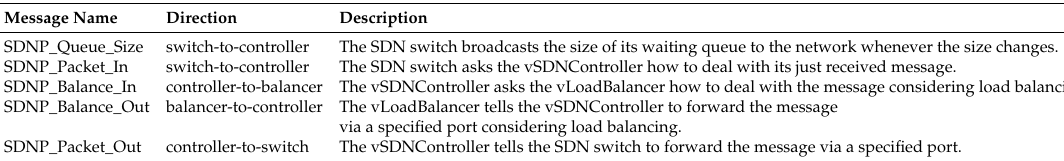
Table 3. Messages used by communication